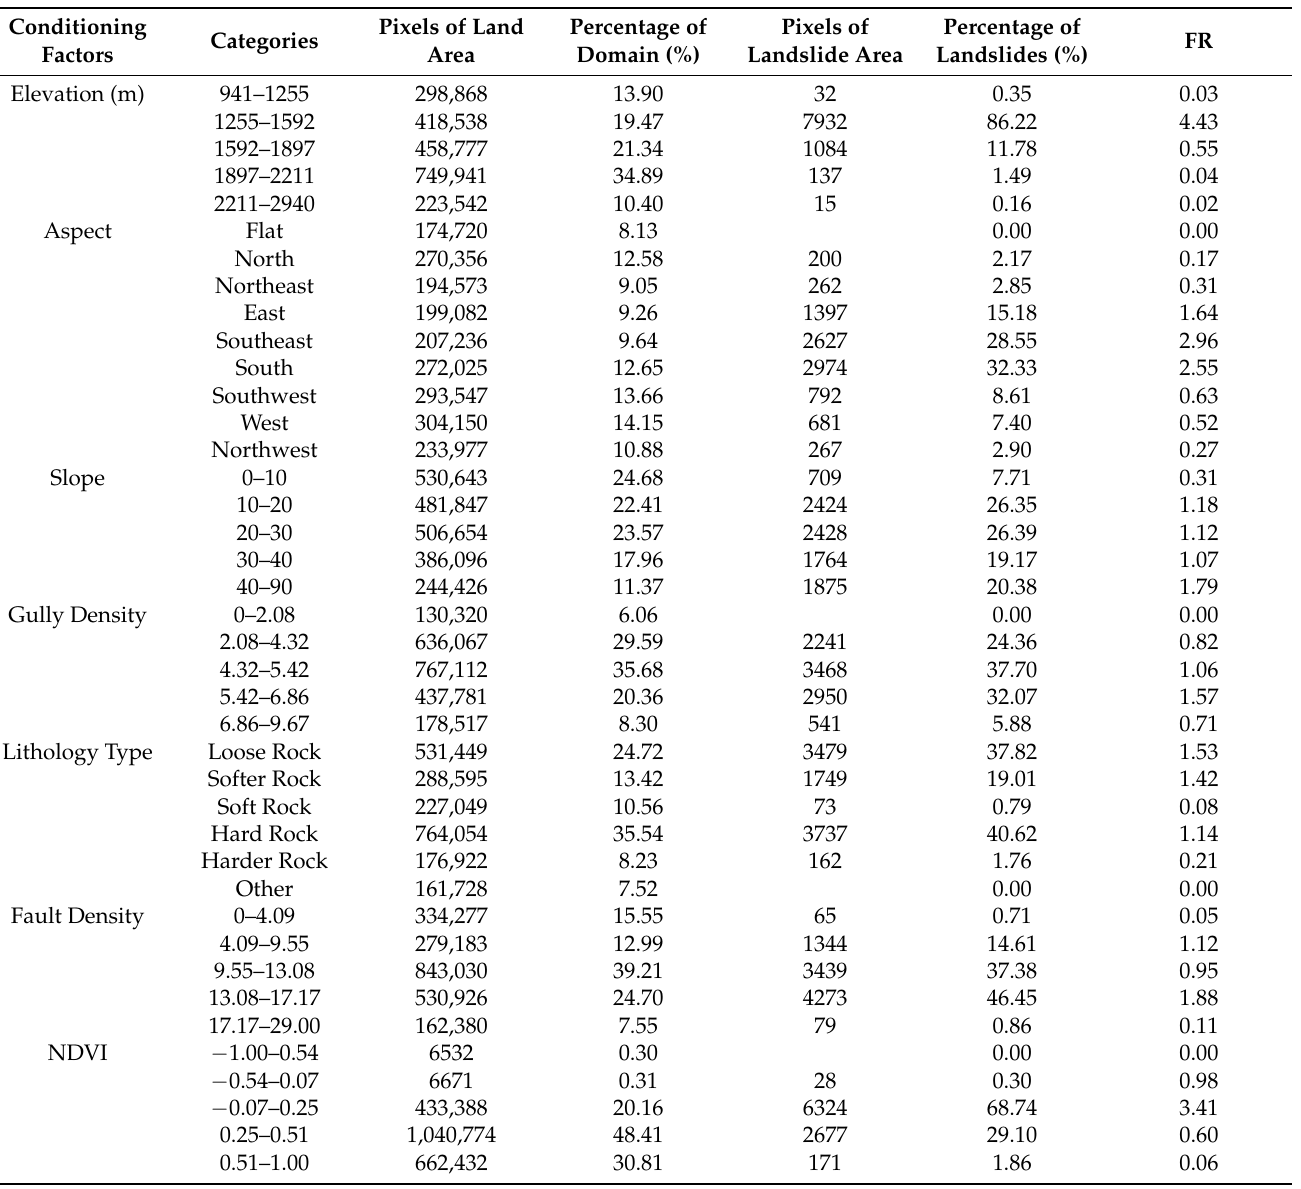
Table 2. The area of landslides and frequency ratio (FR) value of each category for seven landslide- conditioning